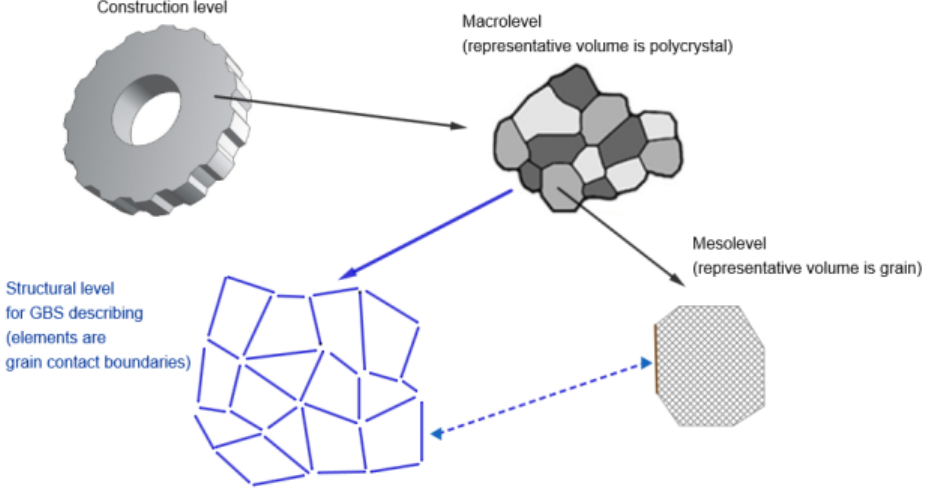
Figure 1. Schematic diagram of the model structure. Additions to a typical statistical crystal plasticity model structure are marked by blue